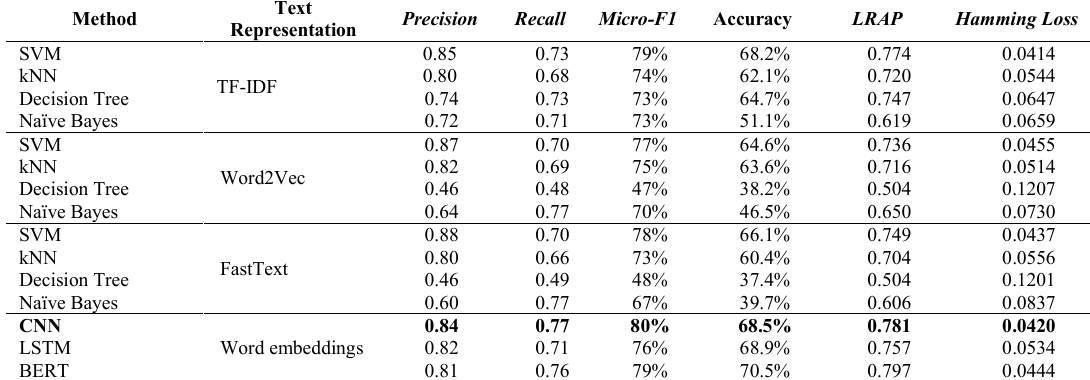
TABLE 2 T HE RESULT OF SINGLE MODEL BASED ON MACHINE LEARNING